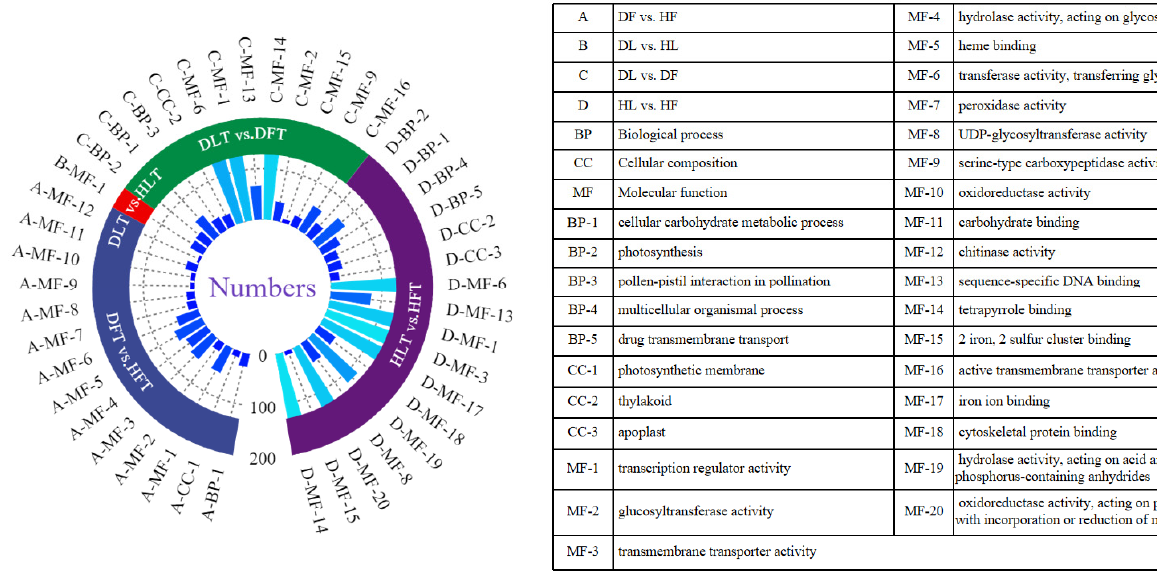
Figure 4. Ring diagram of GO enrichment analysis of the differentially expressed genes of Citrus reticulata Blanco ‘Shatangju’ in response to “ Candidatus Liberibacter asiaticus” infection. In the figure, the different colors represent different functional classifications. DF, diseased fruit pith. DL, diseased leaf. HF, healthy fruit pith. HL, healthy leaf. T, transcriptome analysis. M, metabolome analysis. Different colors on the ring mean different comparison groups. The density of the blue-color bars inside the ring differentiates the number of DEGs enriched in the specific GO terms.